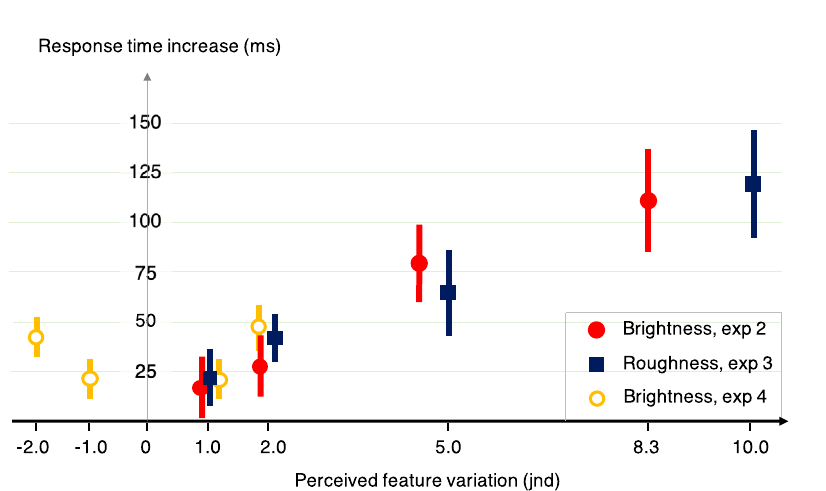
Figure 4. Increase in response time (ms) depending on the singleton perceived feature variations (jnd) in experiments 2, 3, and 4. Error bars represent the standard errors across participants in each condition compared to the no-singleton